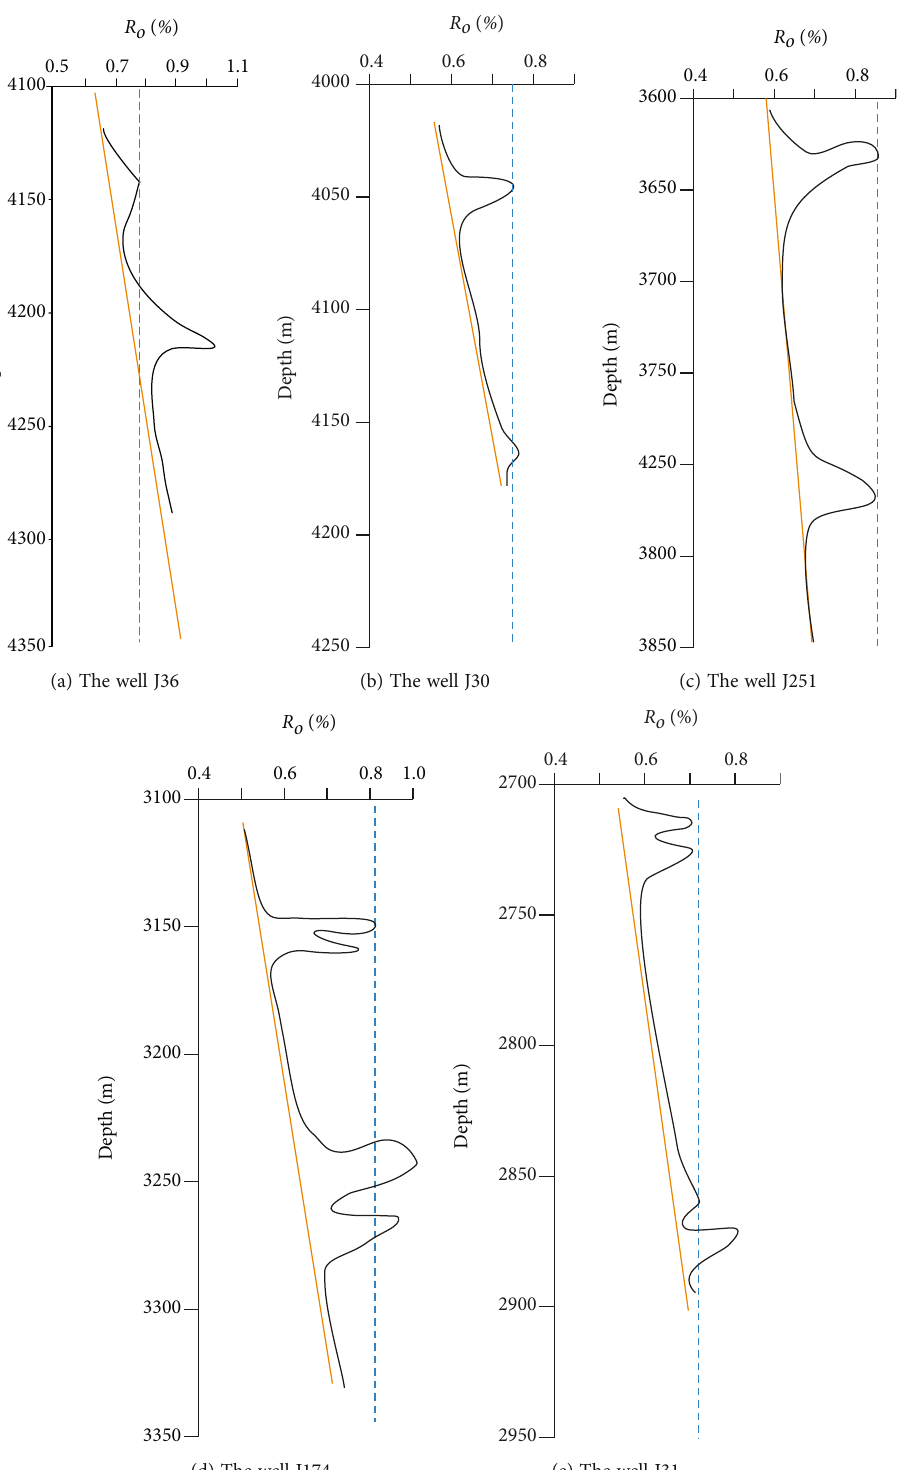
Figure 16: R o -depth evolution map of source rock of Lucaogou Formation in Jimsar Depression (modi